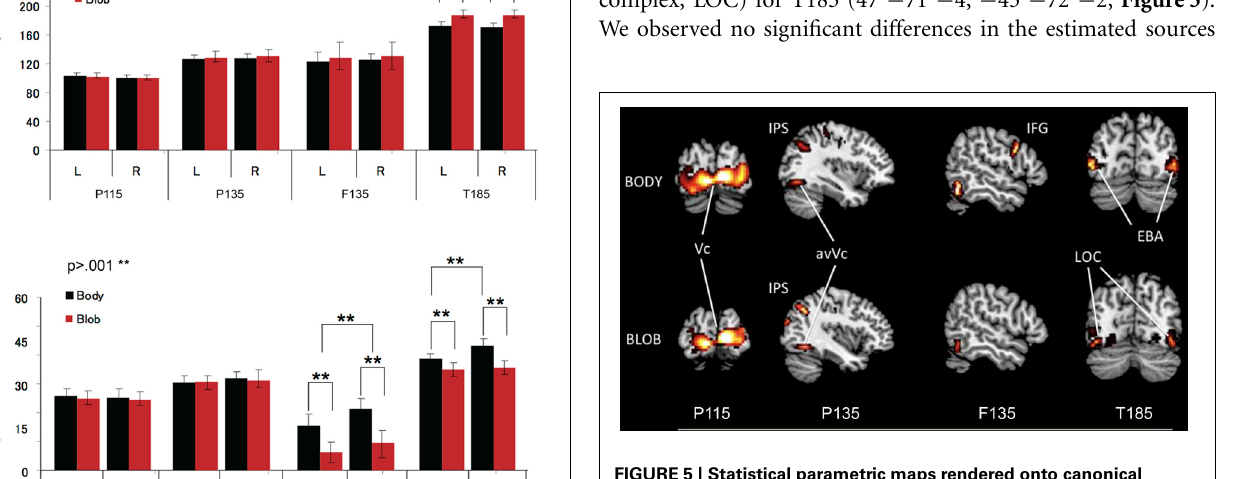
FIGURE 5 | Statistical parametric maps rendered onto canonical anatomical sections showing the t statistic for the “body” (upper) and “blob” (bottom) at each peak latency of P115, P135/F135, and T185 (Vc, visual cortex; anVc, anterior ventral visual cortex; IPS, intraparietal sulcus; LOC, lateral occipital complex; IFG, inferior frontal gyrus; EBA, extrastriate body